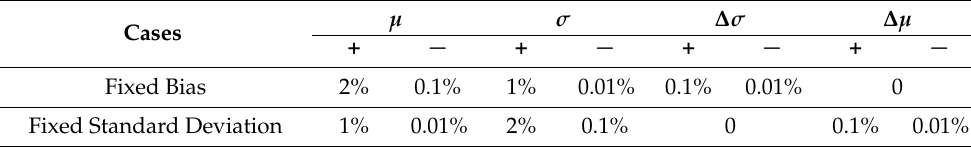
Table 4. Values of each parameter for all of the different